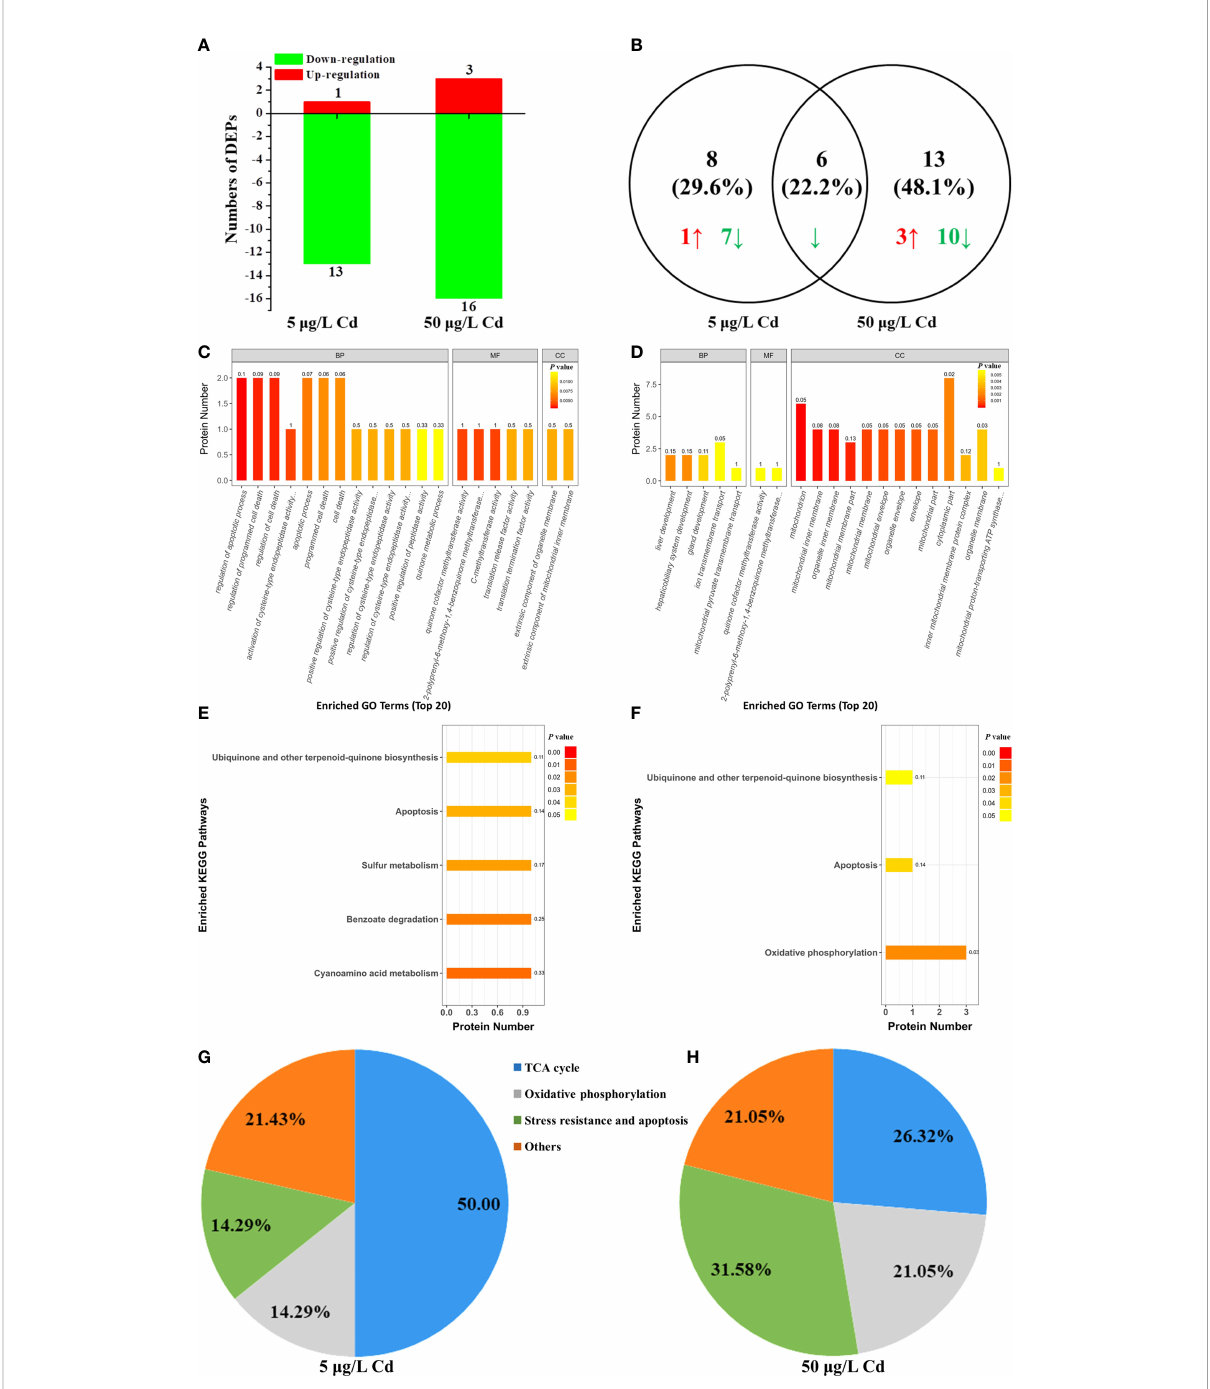
FIGURE 5 iTRAQ-based proteomic analysis of mitochondrial proteins from control, 5 m g/L and 50 m g/L Cd treatments. (A) DEPs numbers in each group. Down- and up-regulated proteins are exhibited in green and red, respectively. (B) venn diagrams of DEPs between 5 and 50 m g/L Cd treatments. Green and red arrows showed the down- and up-regulated DEPs, respectively. (C, D) the 20 most signi fi cantly ( P < 0.05) enriched GO terms based on mitochondrial DEPs of fl ounder livers in 5 m g/L (C) and 50 m g/L (D) Cd treatments. (E, F) the signi fi cantly ( P < 0.05) enriched KEGG pathways based on mitochondrial DEPs of fl ounder livers in 5 m g/L (E) and 50 m g/L (F) Cd treatments. (G, H) functional classi fi cation of liver mitochondrial DEPs in 5 m g/L (G) and 50 m g/L (H) Cd